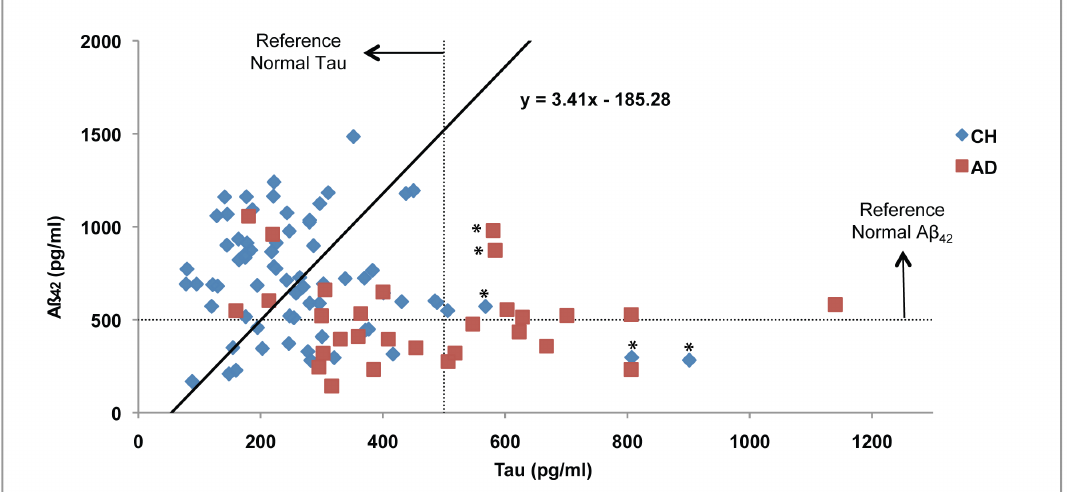
Figure 1. Prediction of AD from individual CSF Aß 42 and Tau concentrations. Levels of Tau are plotted against Aß 42 for each CH (blue diamond) or AD (red square) individual. The diagonal line indicates the regression-derived cutoff for the ratio Aß 42 /Tau that provides 85% sensitivity in discriminating AD participants from CH and MCI participants (MCI participants were used in the regression analysis but their results were excluded in the figure for simplicity): above the diagonal line is healthy, below is AD with 85% probability. The horizontal and vertical (dotted) lines mark the cutoff values for Aß 42 (normal above) and Tau (normal to the left), respectively, from age-appropriate controls [2]. The * denotes individual values that are discussed in the Results